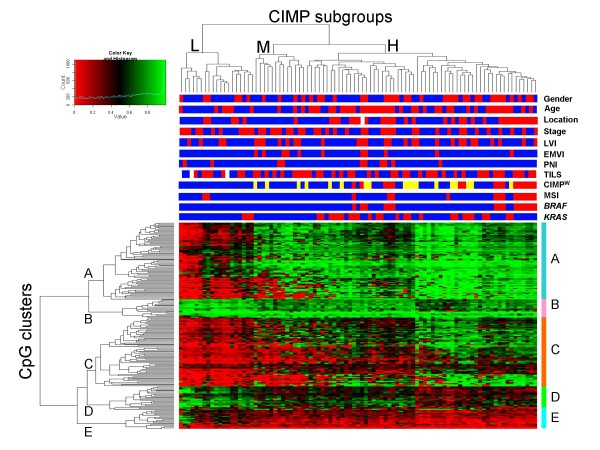
Unsupervised hierarchical clustering of 202 tumor-specific probes (rows) in 91 CRC (columns). The 3 tumor clusters generated by this analysis were termed CIMP-High (CIMP-H), CIMP-Mid (CIMP-M) and CIMP-Low (CIMP-L). Clinicopathological and molecular features are shown above the heatmap. White rectangles are cases with missing data. Gender: female (red), male (blue); Age: ≥ 67 years (red), < 67 (blue); Tumor location: proximal (red), distal (blue); Tumor stage (ACPS): A or B (blue), C or D (red); Lymphovascular invasion (LVI): present (red), absent (blue); Extramural vascular invasion (EMVI): present (red), absent (blue); Perineural invasion (PNI): present (red), absent (blue); Tumor infiltrating lymphocytes (TILS): present (red), absent (blue); CIMPW: CIMPW-high (red), CIMPW-low (yellow), CIMPW-negative (blue); BRAF: mutant (red), wildtype (blue); KRAS: mutant (red), wildtype (blue); Microsatellite instability (MSI): positive (red), negative (blue). Five CpG clusters (A-E) were apparent from the analysis and showed differential methylation amongst the 3 CIMP subgroups.